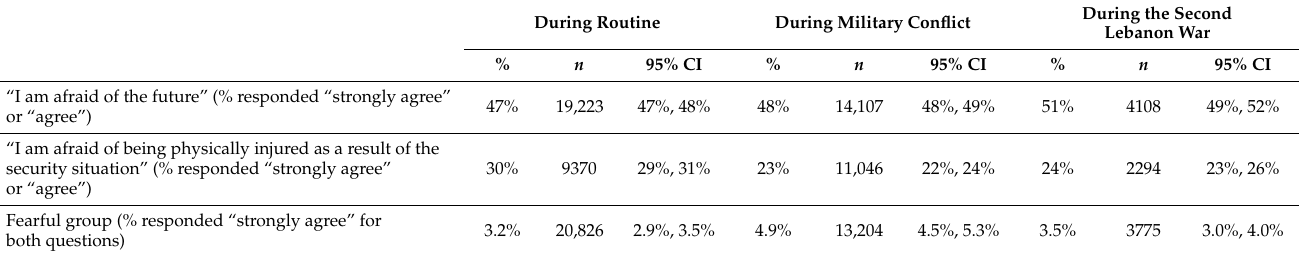
Table 2. Percentage of respondents who answered positively to the statements during military conflicts, and routine periods. During Routine During Military Conflict During the Second Lebanon